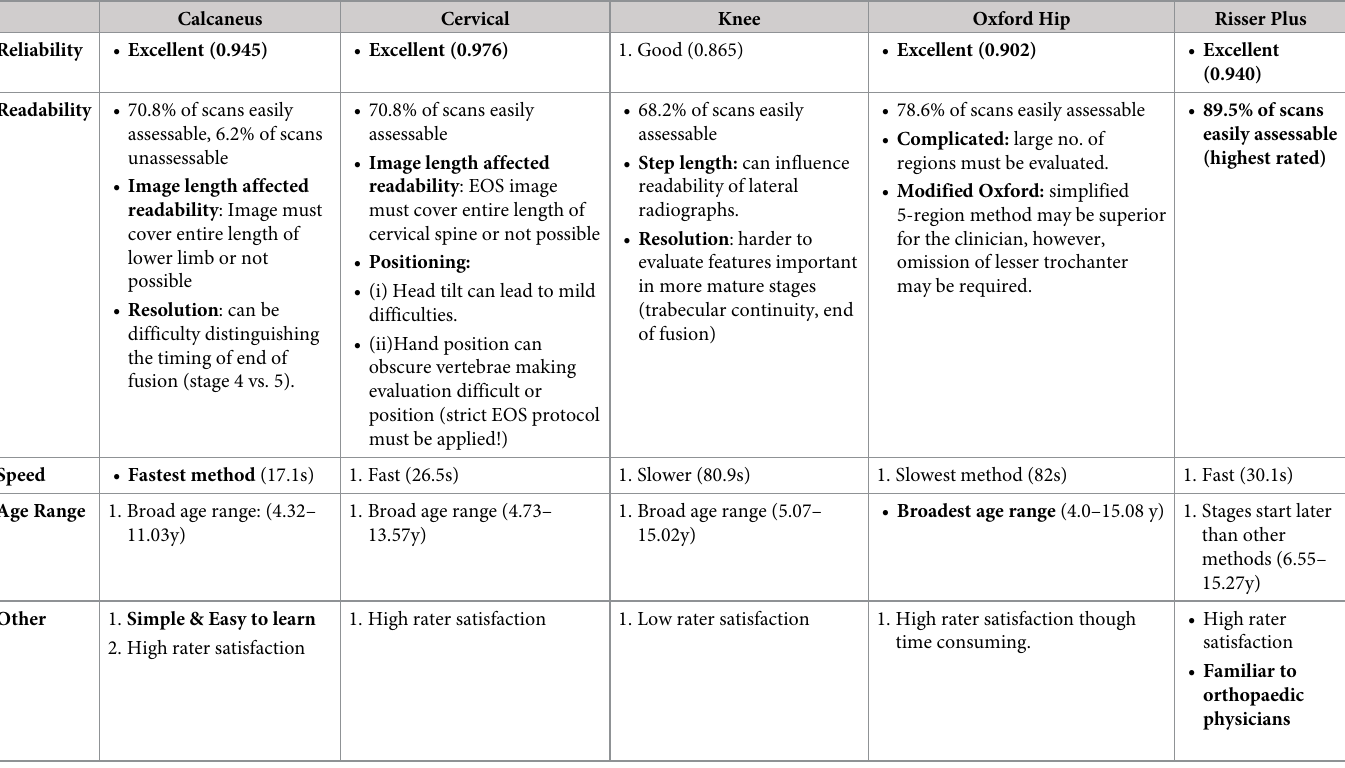
S1 Fig. Alternative bone age methods evaluated. Summaries of the six methods applied in pilot study. See original articles for full details of the individual methods. (All illustrations, unless otherwise stated, are reprinted from O’Sullivan et al. [17], creative commons license: Hassel & Farman (1995). (Adapted with permission from Schle´gl et al. [16]). 1 . Initiation : the inferior borders of C2, C3 and C4 are all flat. Upper borders taper from posterior to anterior giving the body a wedge shape. 2 . Acceleration : C2 and C3 develop concavities in their inferior